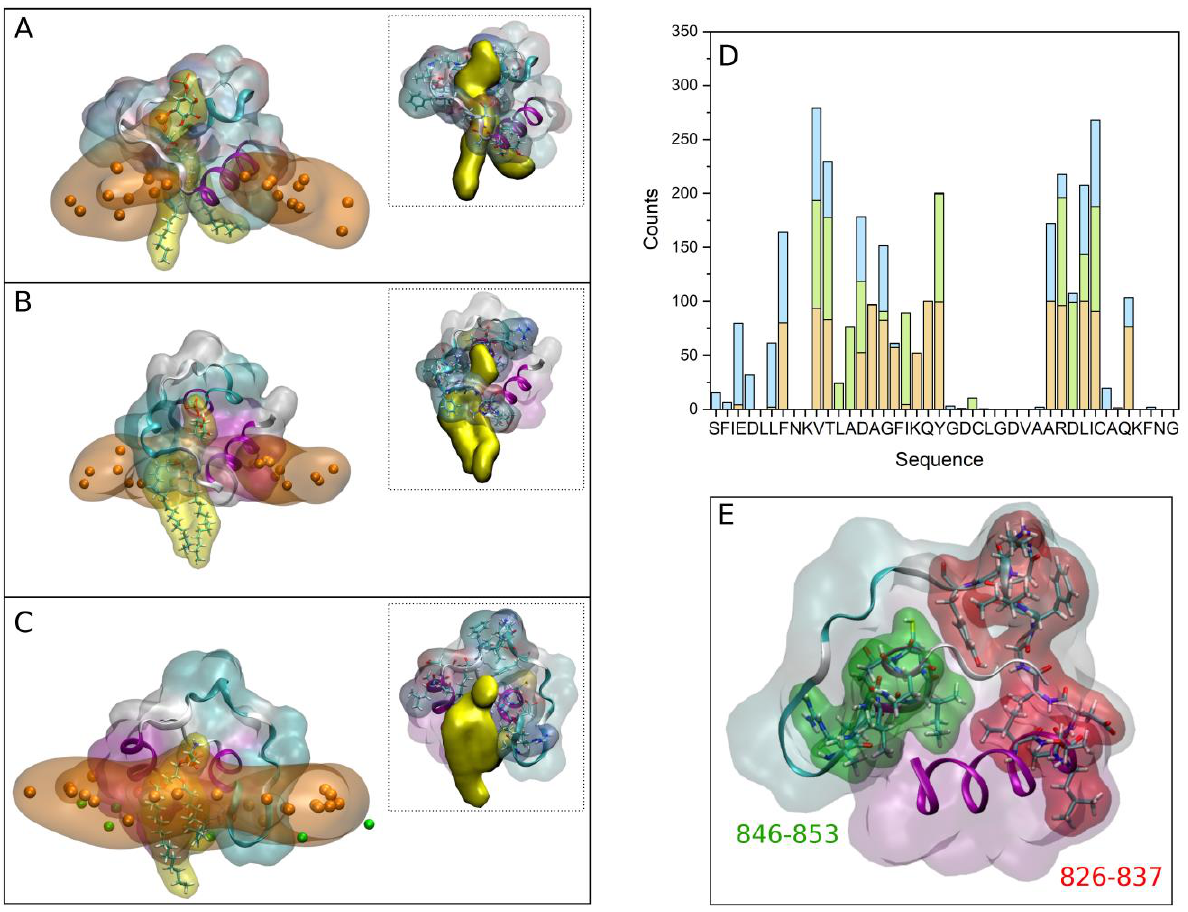
Figure 5. Final composition of the FP with the surrounding phosphate atoms at a distance of 10 Å or less for ( A ) system 2-4, ( B ) system 2-10 and ( C ) system 3-1. The FP is shown in ribbons and transparent surface drawing, whereas the phosphate atoms of the phospholipids are shown in VDW and transparent orange surface drawing. The phospholipid intimately bound to the FP is shown in licorize and yellow transparent surface drawing (PI-3P in ( A , B ) and POPS in ( C )). The inserts in ( A – C ) show the tight association of the FP (ribbons and transparent surface drawing) and the phospholipid (yellow opaque surface drawing), highlighting the residues in contact with the lipid (licorize drawing). ( D ) Histogram of the average of contacts per residue between the FP and the phospholipids in ( A – C ) for the last 30 ns (orange, green and blue, respectively). ( E ) Structure of the FP showing the two binding regions (licorize drawing) observed in ( D ). The FPs are shown with coloured secondary structures (white (coil), violet (helix), yellow (extended), light blue (turns). The oxygen atoms of CHOL are shown in VDW green colour in panel ( C